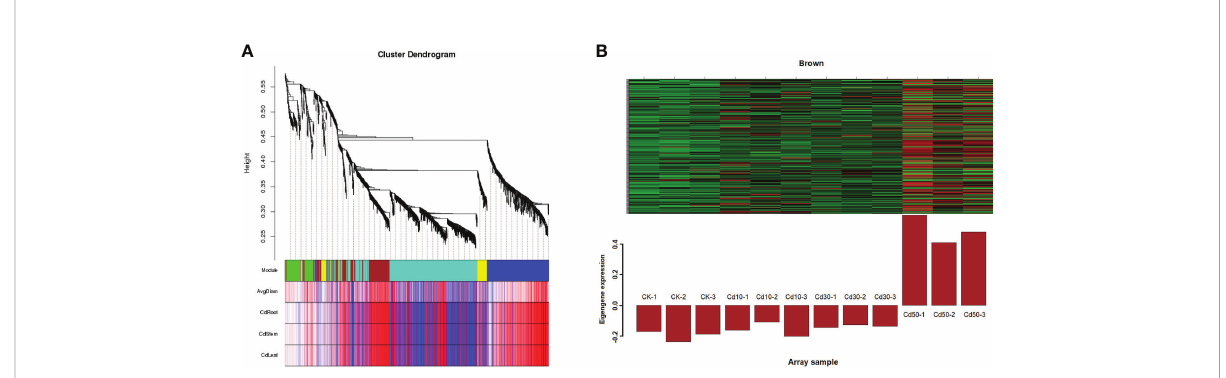
FIGURE 8 Weighted gene co-expression network analysis between traits and modules. (A) Heat map of correlations between modules and traits. In the traits part, the redder the color, the more positive the correlation. A strong correlation existed between genes in the brown module and the traits like ARD, and Cd concentration in different tissues. CK, Cd10, Cd30, Cd50 indicates the Cd concentration 0 mg/L, 10 mg/L, 30 mg/L, and 50 mg/L, respectively. AvgDiam, Average diameter; CdRoot, CdStem, and CdLeaf indicate the Cd concentration in roots, stems, and leaves, respectively. (B) The speci fi c high expression genes under Cd50 treatments in the brown